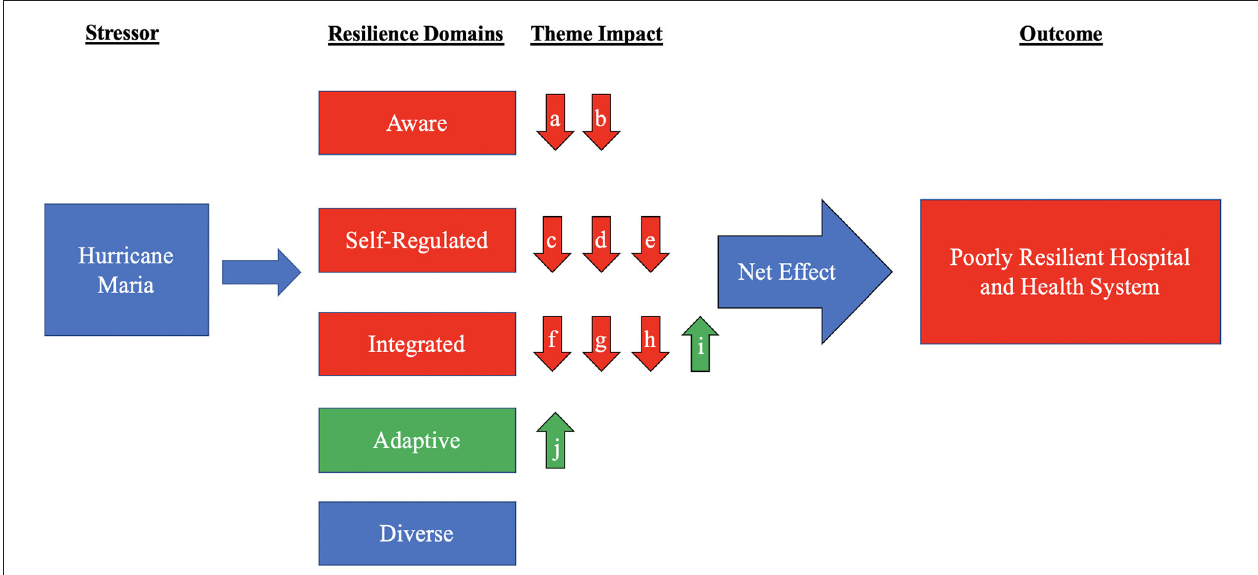
FIGURE 1 | Model explaining poor resilience seen after Hurricane Maria. a Recognizing capacity of back-up generators before Hurricane Maria, b Understanding necessity to transfer ICU patients before Hurricane Maria, c Treating patients with end-stage renal disease patients, d Access to medications for patients with chronic conditions, e Admitting new patients, f Coordinating care with tertiary care centers, g Coordinating with ambulance services, h Response coordination with government i Community trust in hospital and healthcare system, j Staffing adjustment.